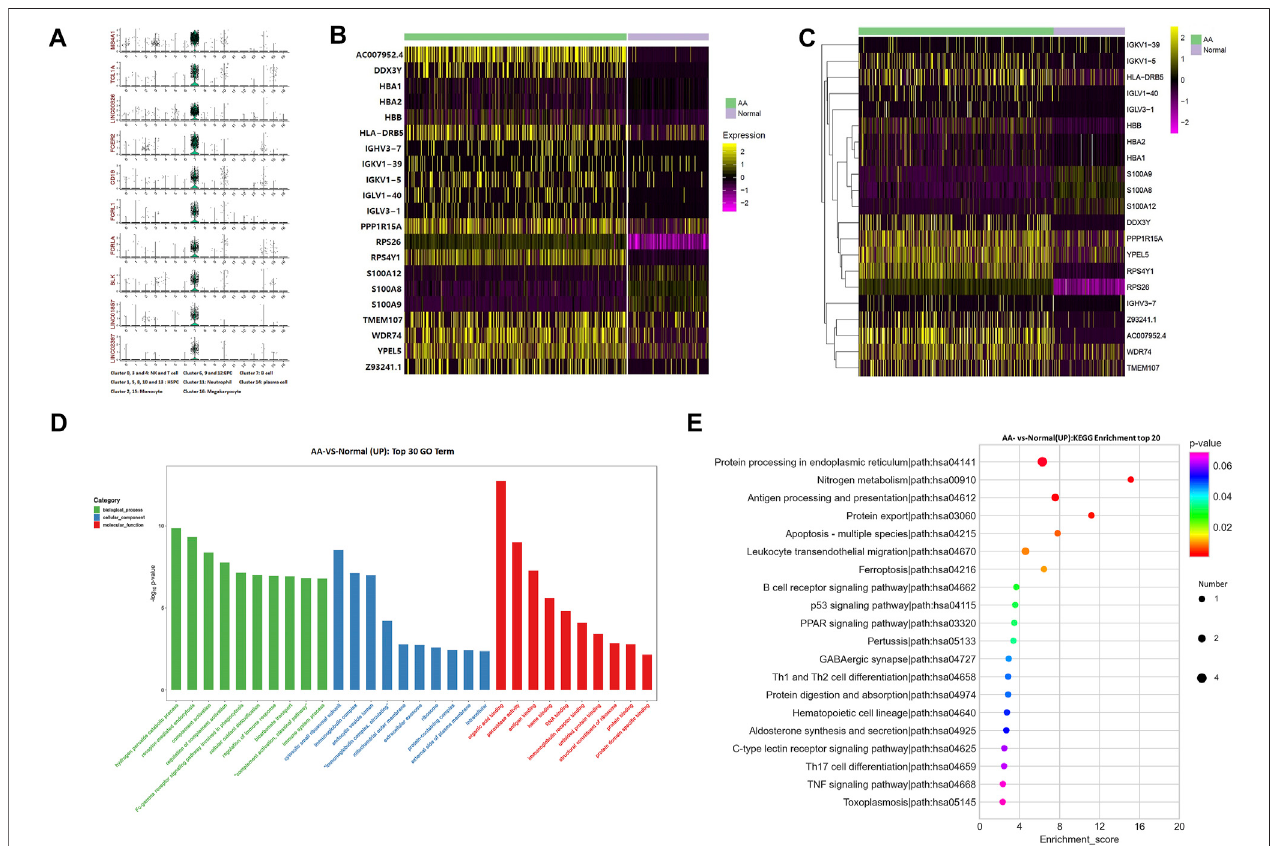
FIGURE 2 | Alterations of B-cell genes in samples from AA patients. (A) Violin plot of the top 10 marker genes in B cells. (B) Heatmap of differentially expressed genes in B cells. (C) Gene clustering of differentially expressed genes in B cells. (D) GO analysis of differentially expressed genes in B cells. (E) KEGG pathways of differentially expressed genes in B